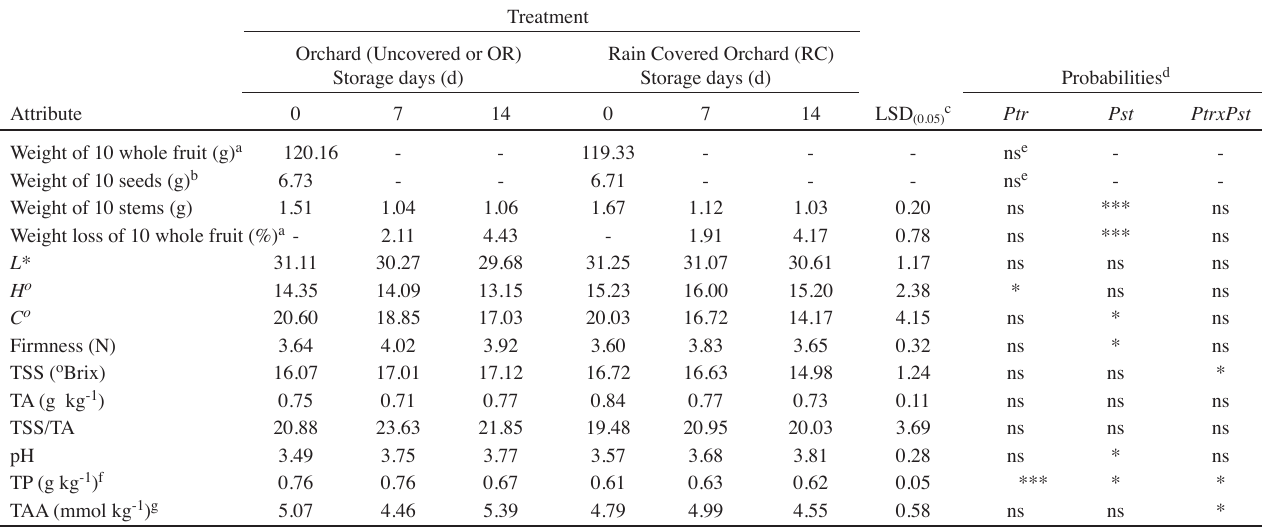
Tab. 5: Effects of rain cover on quality attributes in ‘Noire de Meched’ cherries at harvest and after storage, in 2011.